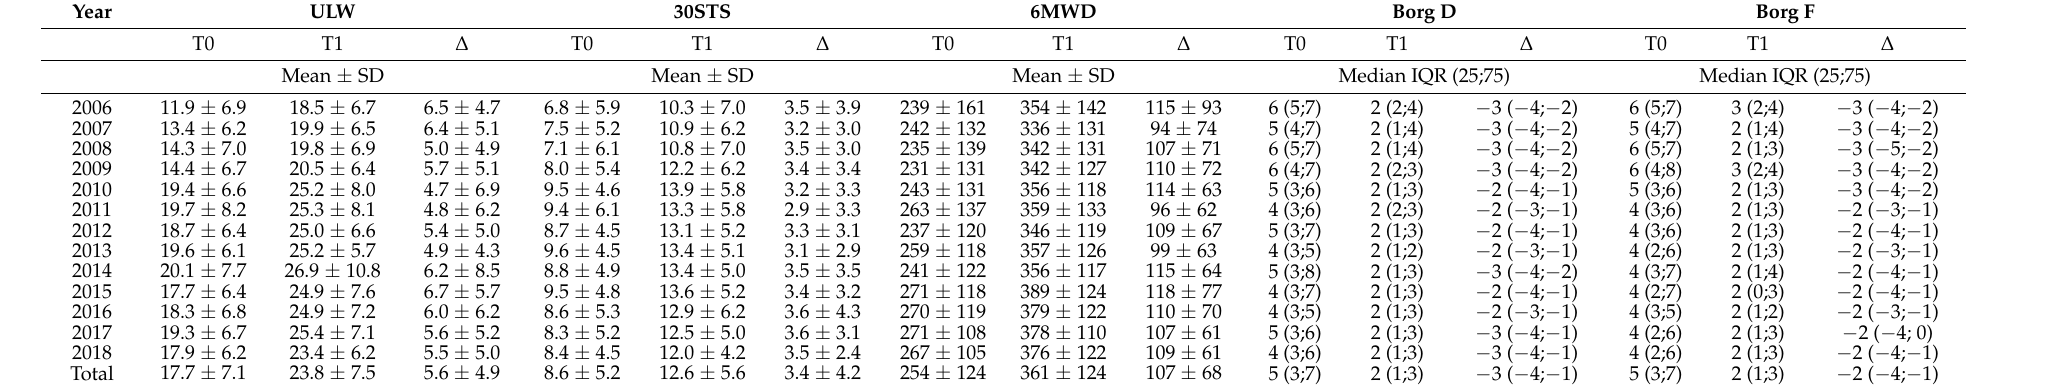
Table 2. Outcome changes over the CR course and during the considered